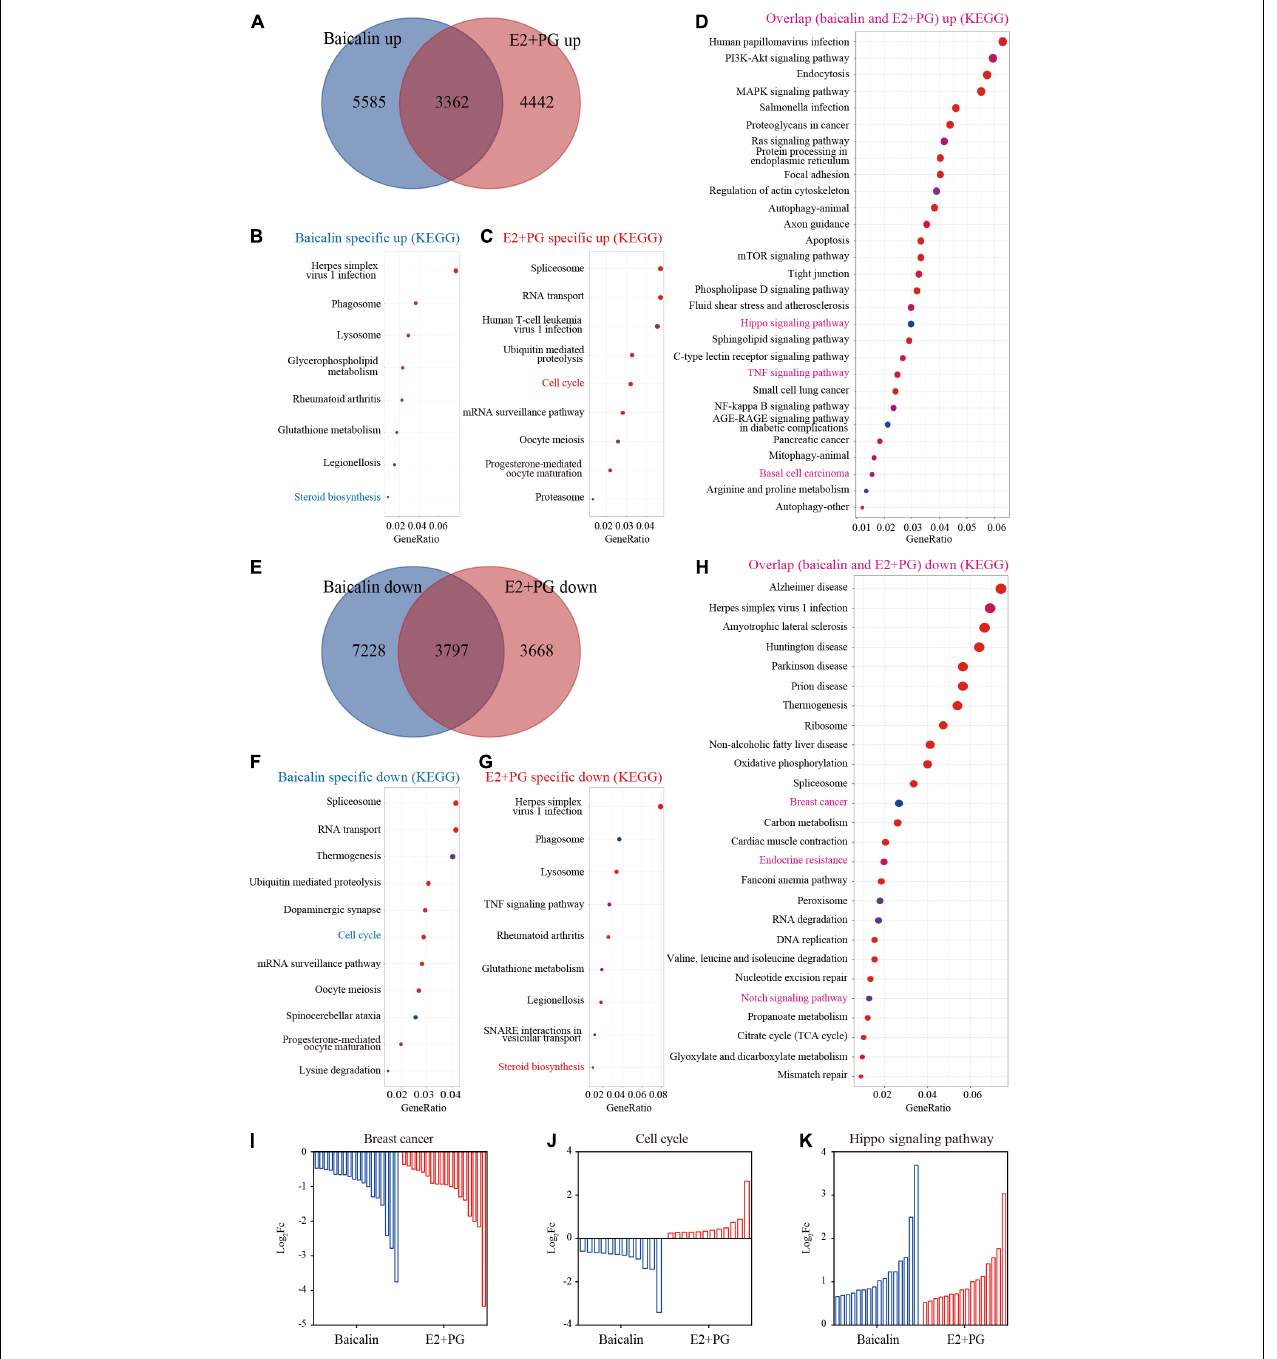
FIGURE 6 | Transcriptome analysis of luminal cells treated with baicalin or E2 + PG. (A) Venn diagram showing the overlap of genes up-regulated in 3D-cultured luminal cells treated with baicalin or E2 + PG. (B,C) Enriched pathways from KEGG analysis of genes up-regulated in luminal cells treated with baicalin (B) and E2 + PG (C) . (D) Enriched pathways from KEGG analysis of genes in luminal cells up-regulated by both baicalin and E2 + PG. (E) Venn diagram showing the overlap of genes down-regulated in 3D-cultured luminal cells treated with baicalin or E2 + PG. (F,G) Enriched pathways from KEGG analysis of genes down-regulated in luminal cells treated with baicalin (F) and E2 + PG (G) . (H) Enriched pathways from KEGG analysis of genes in luminal cells down-regulated by both baicalin and E2 + PG. (I) Representative pathway (breast cancer) down-regulated by baicalin and E2 + PG. (J) Representative pathway (cell cycle) down-regulated in luminal cells by baicalin, but up-regulated in luminal cells by E2 + PG. (K) Representative pathway (Hippo pathway) up-regulated in luminal cells by baicalin and E2 + PG.